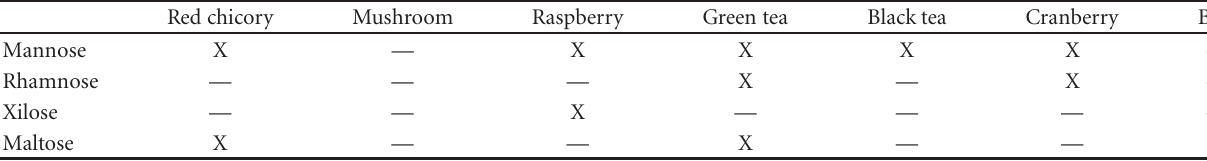
Table 3: Monomeric and dimeric sugars presence in the selected food/beverages.